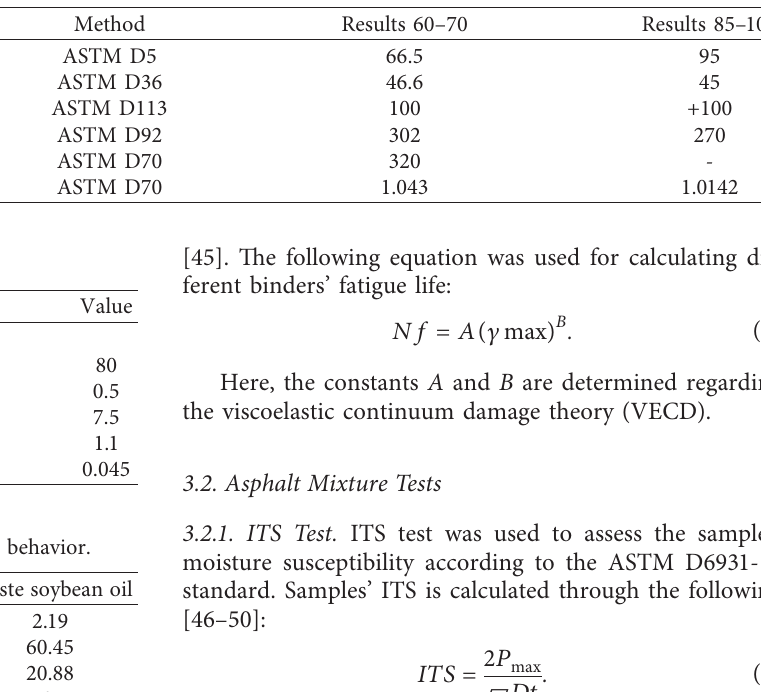
Table 3: Properties of the binder.